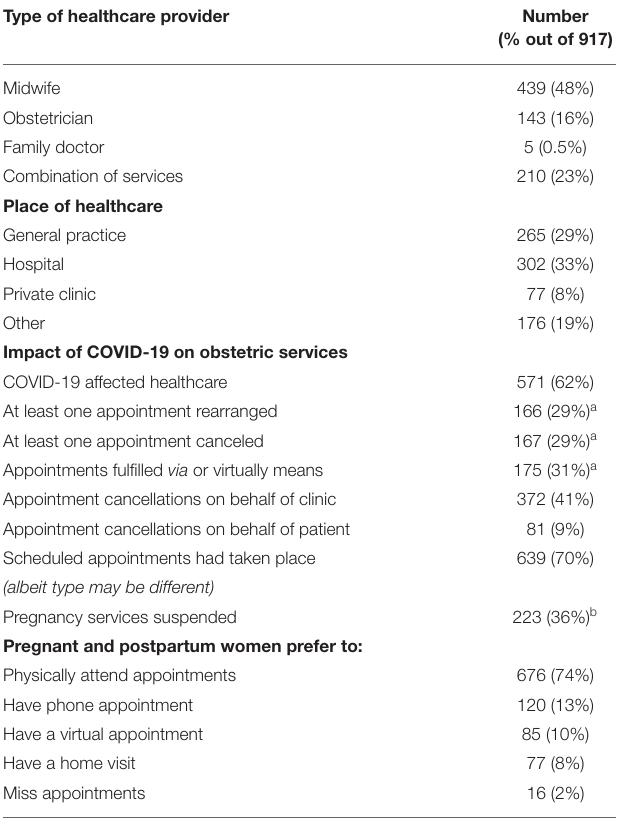
TABLE 2 | Type and access to obstetric care during the COVID-19 pandemic. Type of healthcare provider